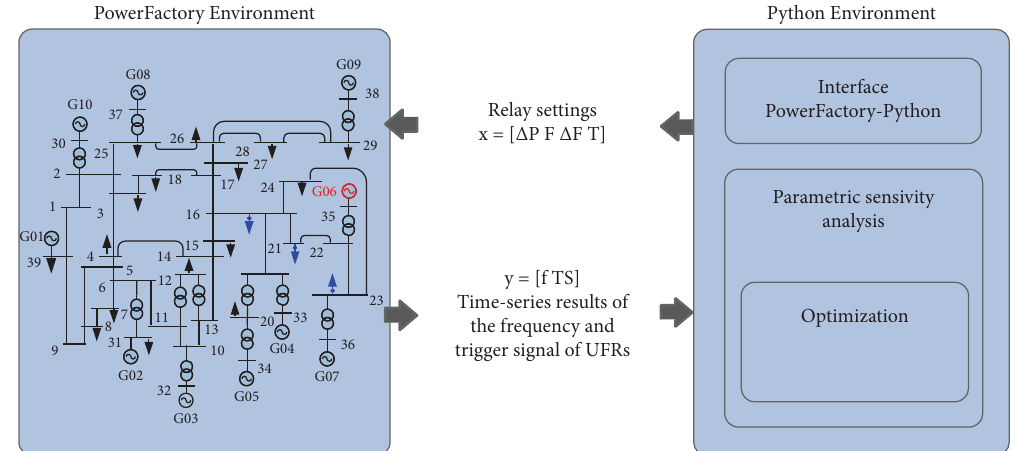
Figure 4: Conceptual joint simulation outline implemented to solve the optimal UFLS problem.